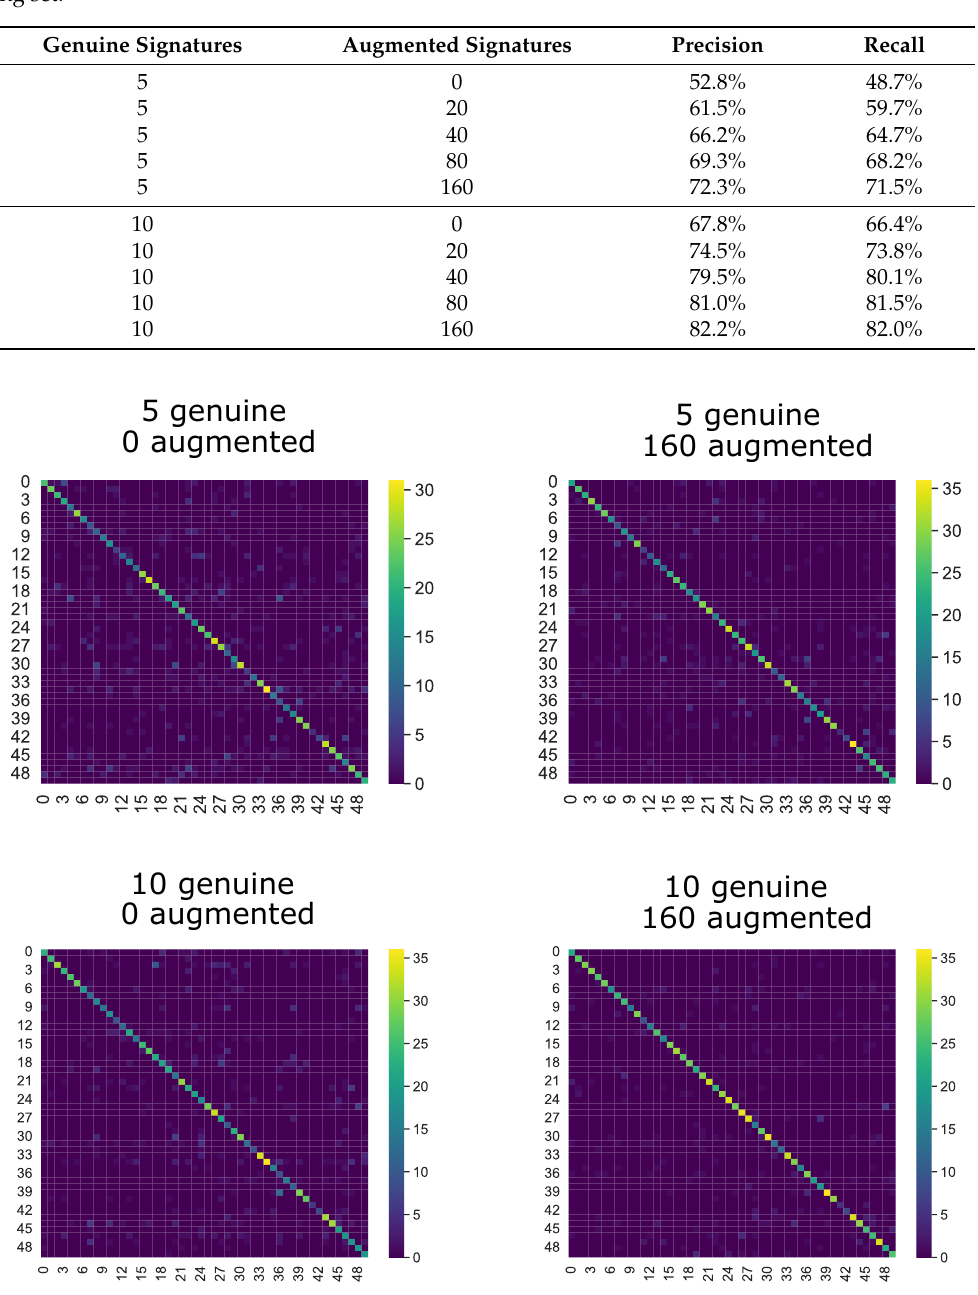
Figure 7. Confusion matrices generated by evaluating the test set with different training sets com- posed of different amounts of genuine and augmented signatures per